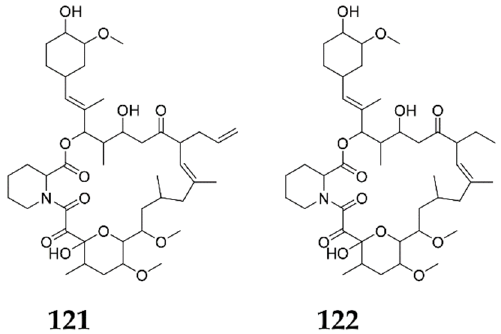
Figure 10. Secondary metabolites elicited by cumulative chemical elicitors and combinatorial engi- neering.